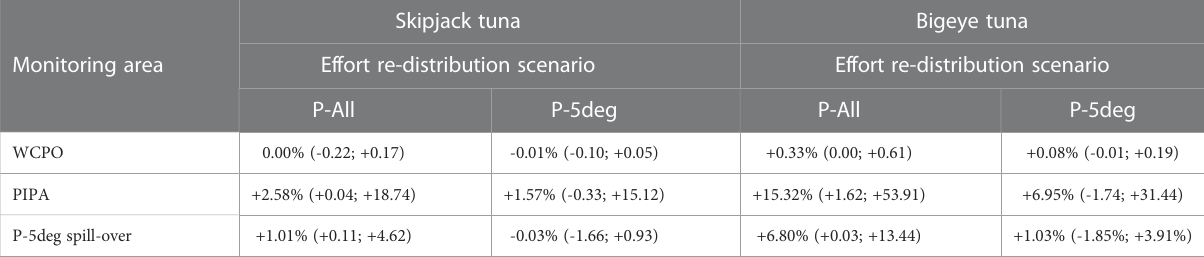
TABLE 1 Average impact 1 (monthly range in parentheses) on skipjack and bigeye tuna spawning biomass ( SB ) of hypothetical PIPA closures during 1998-2019 for two catch/effort redistribution scenarios for 1998-2014 – proportionate redistribution to the same fl eets operating in non- PIPA area (P-All) and reallocation to the area within fi ve degrees of the PIPA boundary (P-5deg).